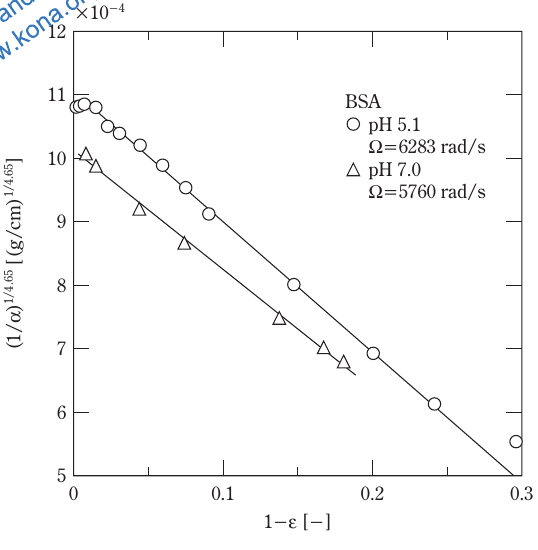
Fig. 8 Relation between local specific flow resistance and poros- ity of solution.